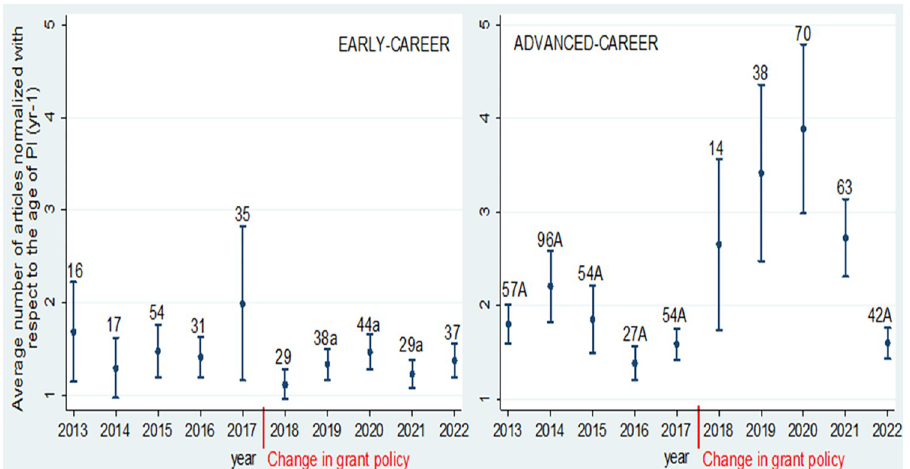
Fig 8. The average ± SE number of peer-reviewed articles normalized with respect to the age of the researcher (Eq. 1) for PIs of early and advanced-career grants. The number of grants gained in particular year is given above the intervals. a–differs significantly from the average of advanced level; A–differs significantly from the average of years 2019, 2020 and 2021 (comparison between the years is within the particular career level, two-sample Wilcoxon rank- sum test, P < 0.05). EP-Expert Panel; EC-Evaluation Committee, both play important role in final decision making over funding